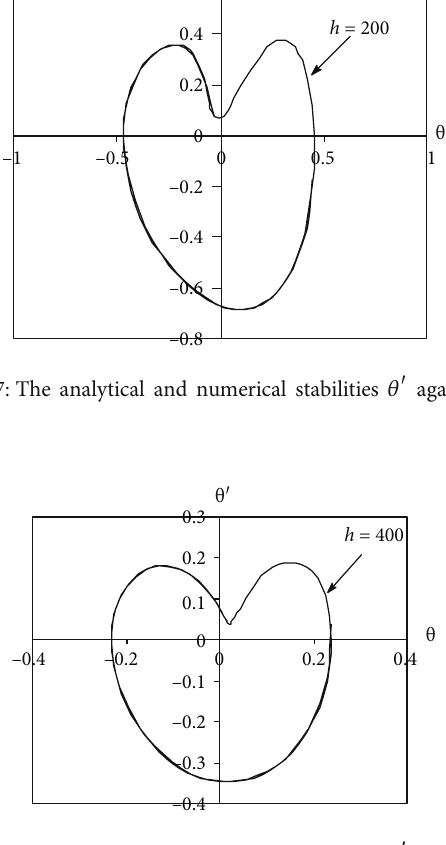
Figure 8: The analytical and numerical stabilities θ ′ against θ at h = 400